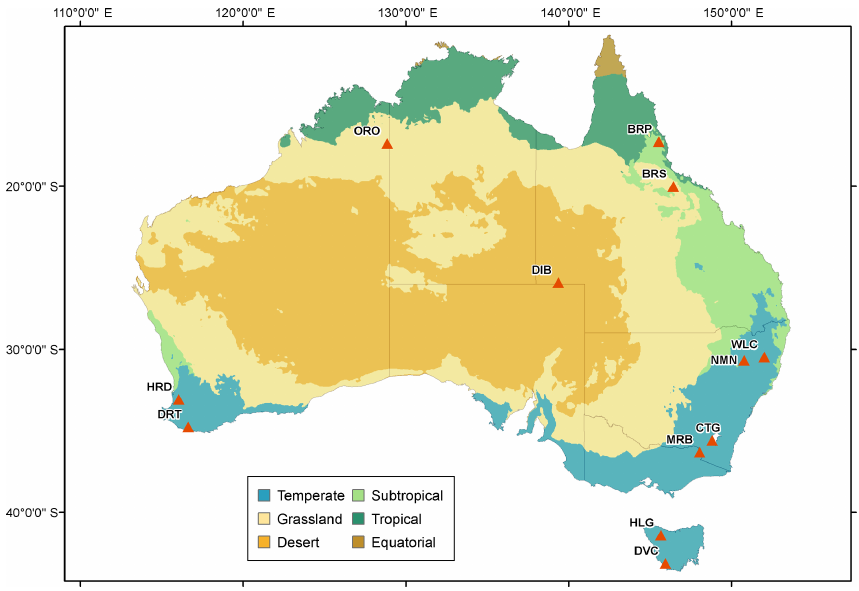
Figure 1. Map of Australian climate zones overlaid by gauging locations plotted as red triangles and labelled with catchment ID. Details of the catchments, including size, are presented in Table